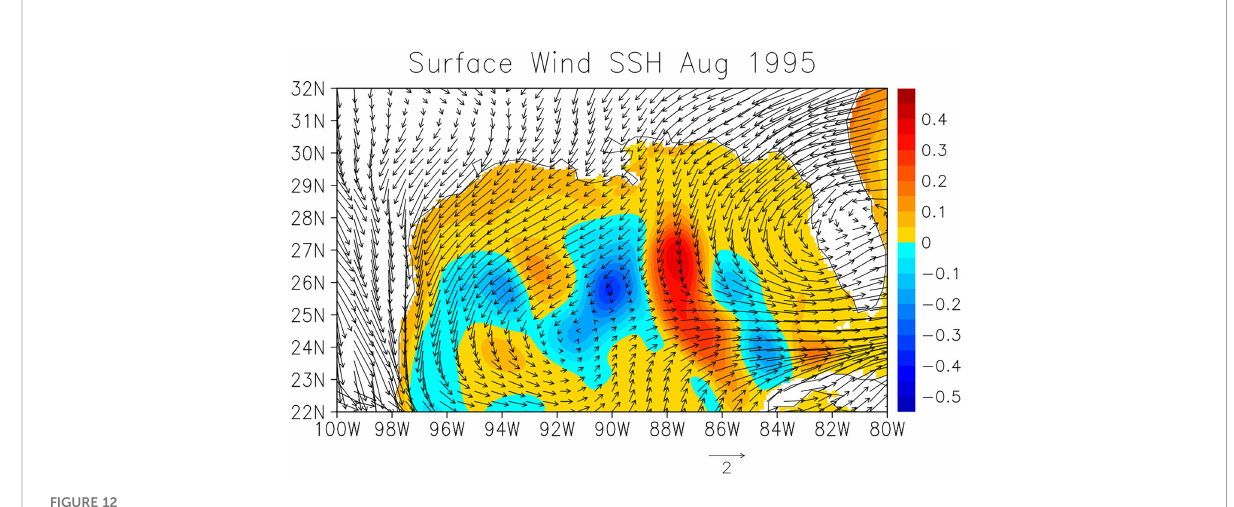
FIGURE 12 Same as Figure 10 except for August, 1995.